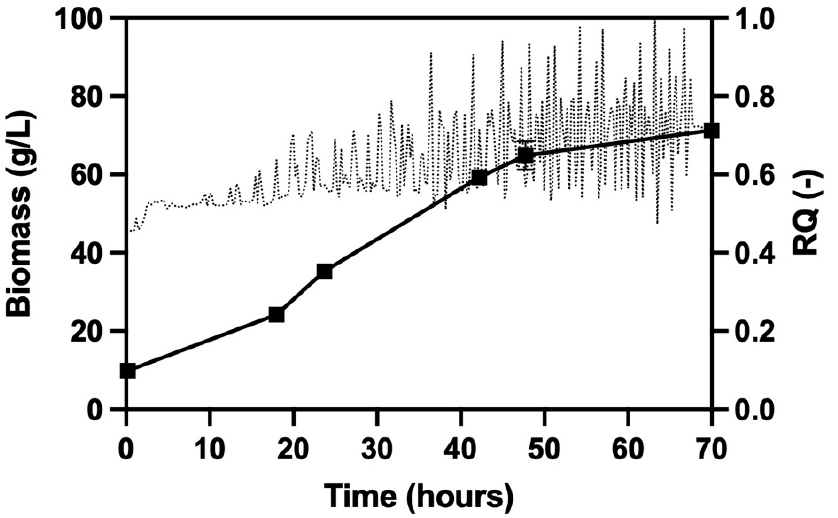
Figure 3. Biomass concentration ( ■ ) obtained throughout the course of the propagation in fed-batch mode. The RQ ( …… ) represents the ratio between the CO 2 produced and the oxygen consumed. The values are averages of two duplicates. Standard deviations of biomass concentrations are shown. Table 3. Relevant process parameters observed during propagation of S. cerevisiae cV-110 on ethanol and glycerol in fed-batch mode in an automatic